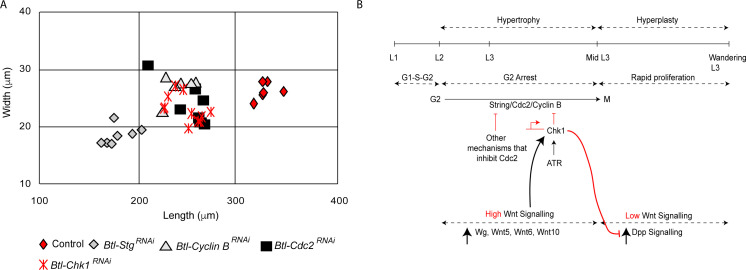
Loss of Stg, Cdc2 or Cyclin B perturbs hypertrophic growth of Tr2 DT.(A) Impact of reduction of Chk1 or different drivers of G2-M on the size of Tr2 DT at 32–40 h L3. Scatter plot shows length and width of Tr2 DT from Wild type, Btl-Chk1RNAi (btl-GAL4/UAS-Chk1RNAi), Btl-StgRNAi (btl-GAL4/+; UAS-StgRNAi/+), Btl-Cdc2RNAi(btl-GAL4/UAS-Cdc2RNAi) and Btl-CyclinBRNAi (btl-GAL4/+; UAS-CyclinBRNAi/+) at 32–40 h L3. Values shown in red are from data previously published in Kizhedathu et al., 2018. (n ≥ 6 tracheae). (B) Model for the regulation of G2 arrest by Wnt signaling. Wnt signaling negatively regulates G2-M by transcriptionally upregulating Chk1. Arrest in G2 negatively regulates Dpp signaling, preventing precocious proliferation and allowing for hypertrophic growth of Tr2 DT.